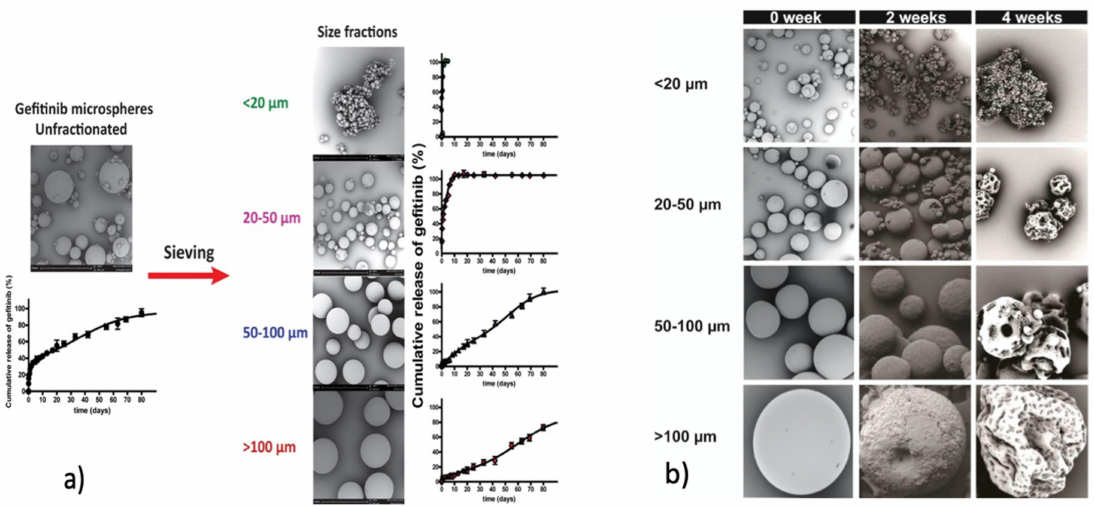
Figure 9. ( a ) Effect of particle size on in vitro release of gefitinib-loaded PLGA microspheres. ( b ) SEM micrographs of gefitinib-loaded PLGA microspheres upon in vitro incubation in buffer of pH 7.4 and at 37 ◦ C. Adapted with permission from ref. [71]. 2017, ACS